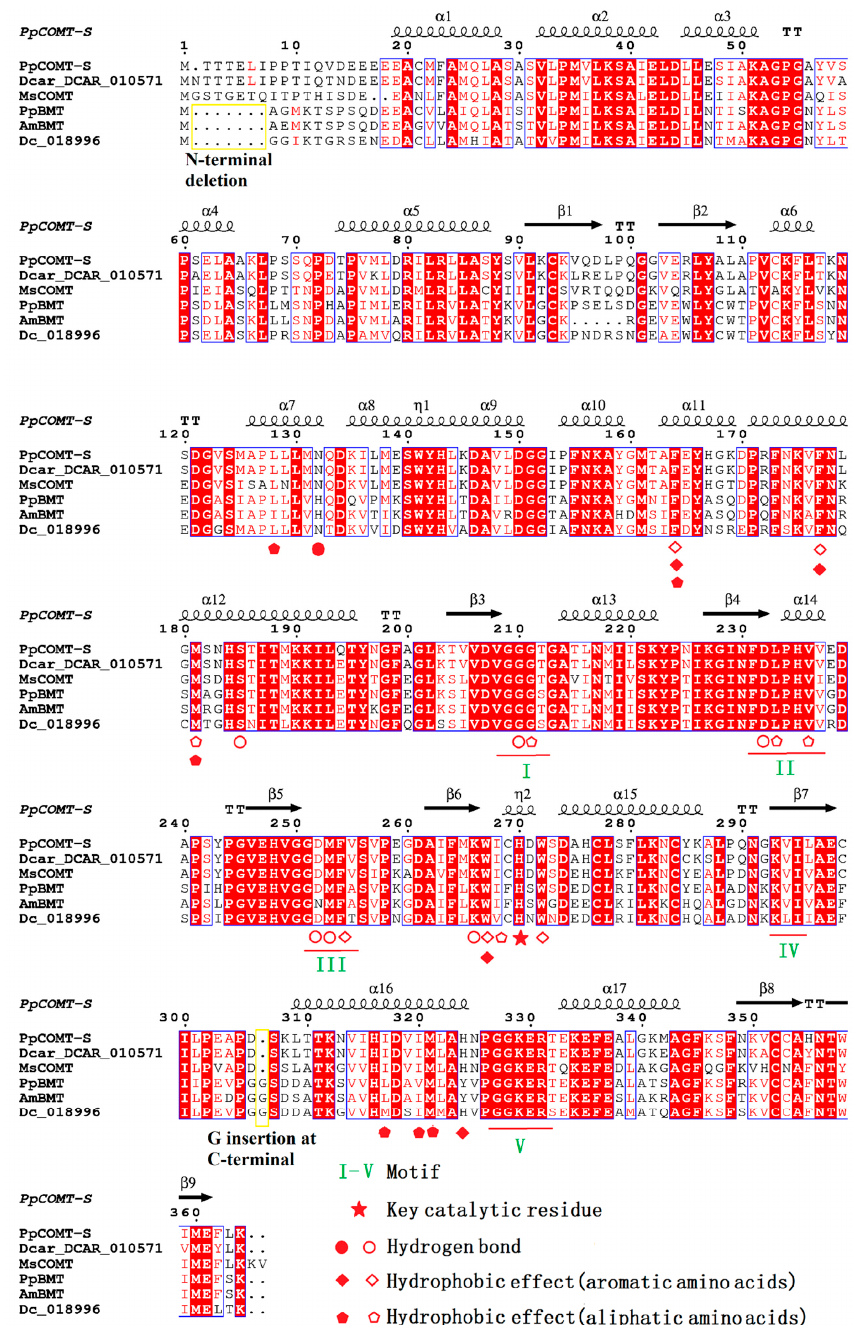
Figure 5. Structural and sequence alignment of representative OMTs. The accession numbers of the six representative OMTs are ANA75355.1 of PpBMT, AY443006 of AmBMT, and 010571/018996 in the D. carota genome. The secondary-structural elements occurring in the COMT-S structure are indicated above and the alignment with helix ( α -helices) and right arrow ( β -strands). Numbering of COMT-S is also labeled above with every 10th position dotted. The motifs of COMT are marked with I to IV and the key catalytic residue is indicated with a star. Residues involved in hydrogen, hydrophobic effect with aromatic amino acids, and hydrophobic effect with aliphatic amino acids are marked with a circle, quadrilateral, and pentagon, respectively. The solid and hollow of the shapes are specific for bergaptol and SAH. BMT and COMT from different species are marked with a yellow rectangular box and N-terminal deletion in BMT and G (glycine) insertion in C-terminal are marked with a vertical